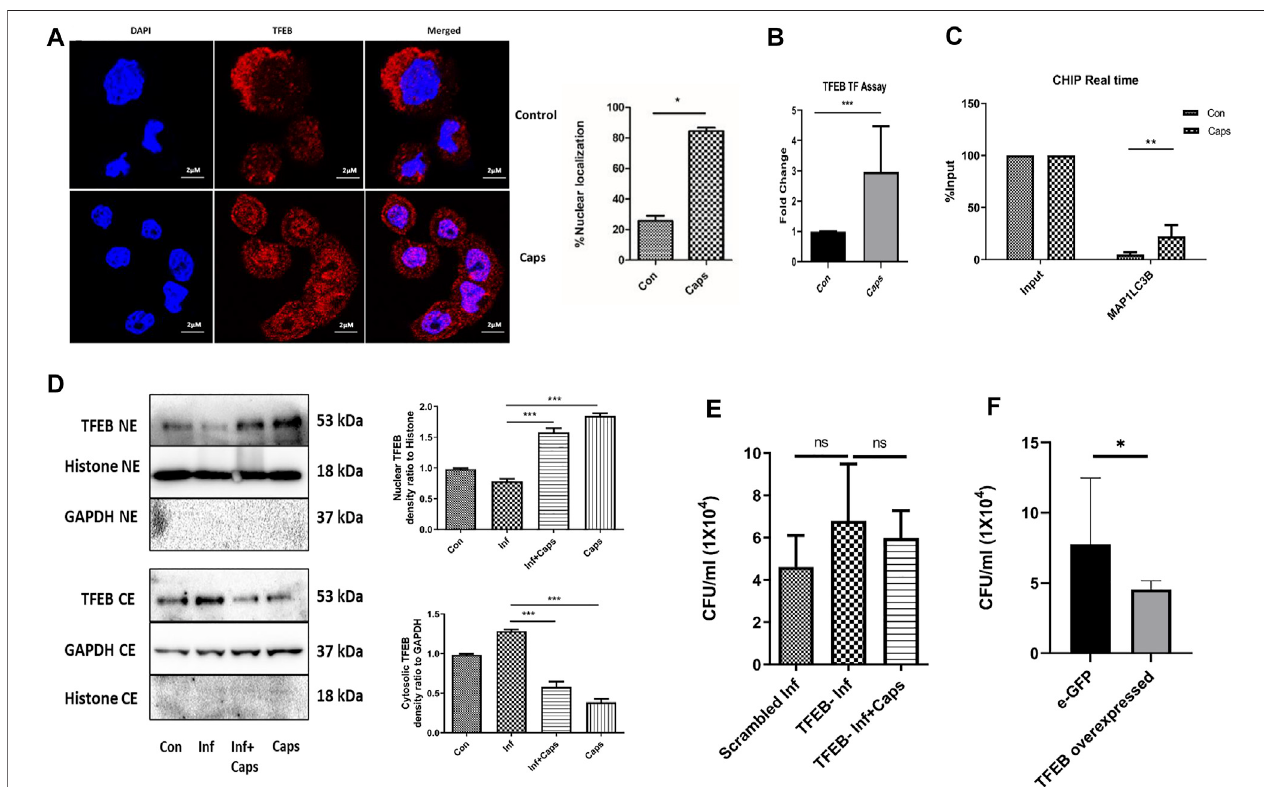
FIGURE 6 | Caps treatment induced TFEB nuclear localization. (A) Confocal microscopic data showing nuclear localization of TFEB upon Caps treatment. Brie fl y, HT29cellsweretreatedwithCaps(16 μ M)for2 hfollowedbyimmuno fl uorescencemicroscopy.Scalebar:2 μ m. (B)